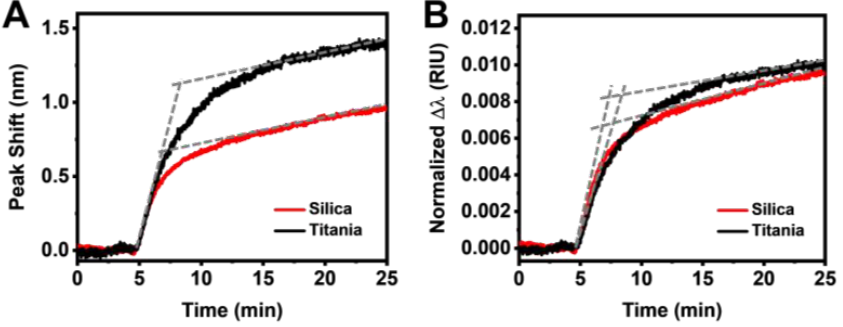
Figure 3. ( A ) LSPR peak shift responses as a function of time for HSA adsorption onto silica- and titania-coated sensors before normalization; and ( B ) the normalized LSPR peak shift responses as a function of time for HSA adsorption from panel ( A ).